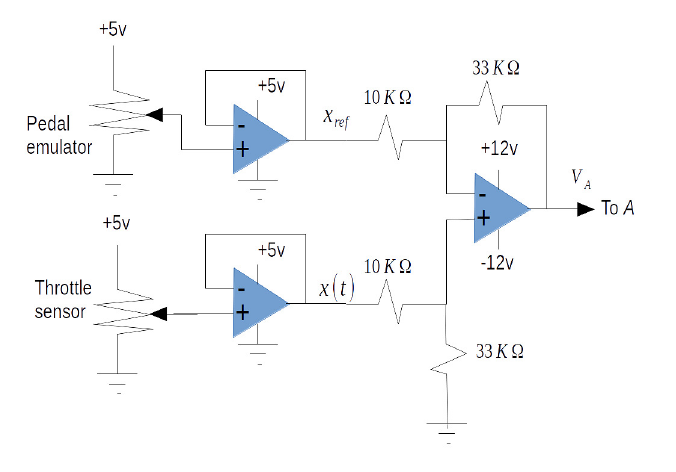
Figure 4. Analog electronic circuit: the error signal processing unit. Its response is then sent to the circuit in Figure 5. The operational amplifiers employed are inside the LM 741 integrated circuit.